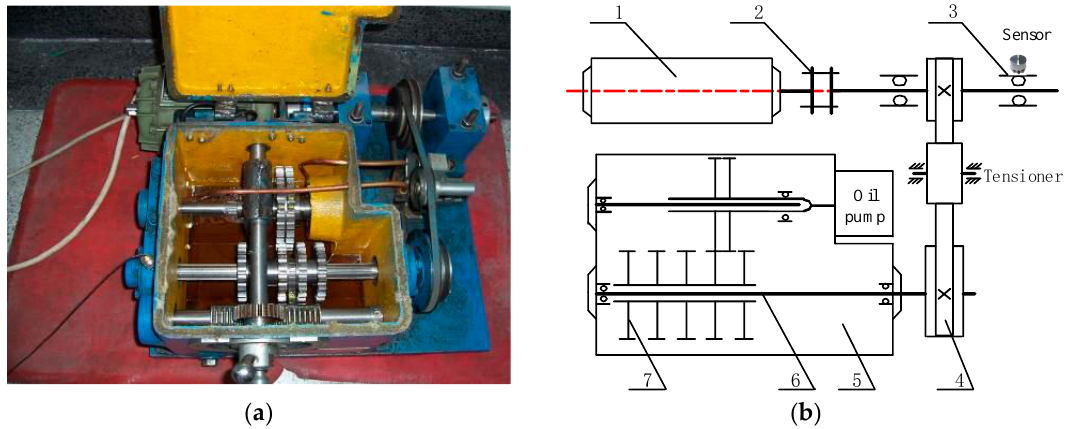
Figure 6. Gear-bearing comprehensive failure device: ( a ) test rig general view; ( b ) structure diagram of